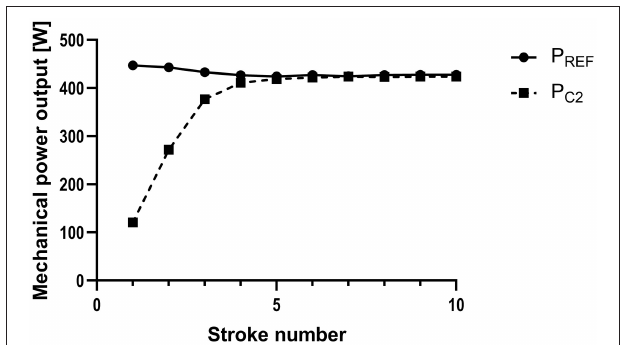
FIGURE 3 | Mechanical power output measured by a reference system of a test rig (P REF ) and calculated by the Concept 2 Indoor Rower’s PM5 Monitor (P C2 ) for the starting strokes (1–10), when the flywheel is accelerated from standstill. Exemplary data from one measurement with steady rowing strokes (using mid-emphasized